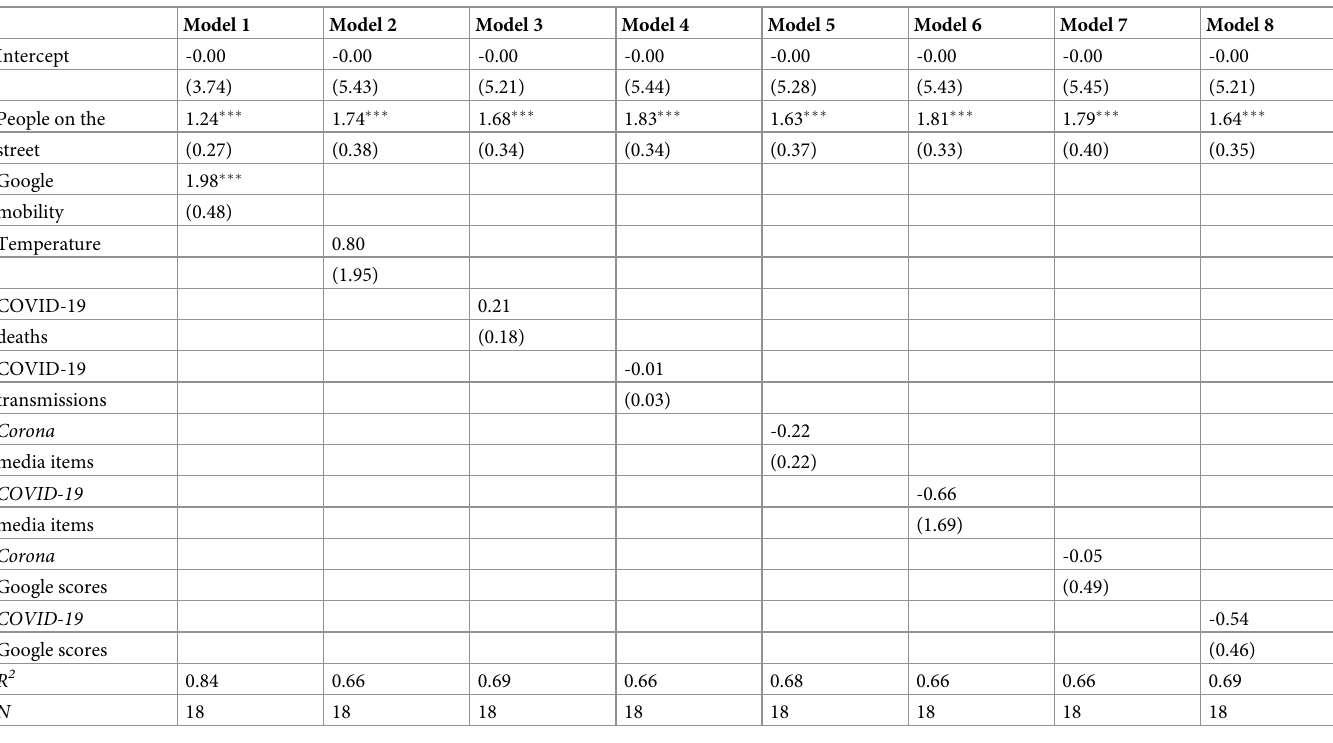
Table 2. Number of social distancing violations regressed on the number of people on the street and each of the other